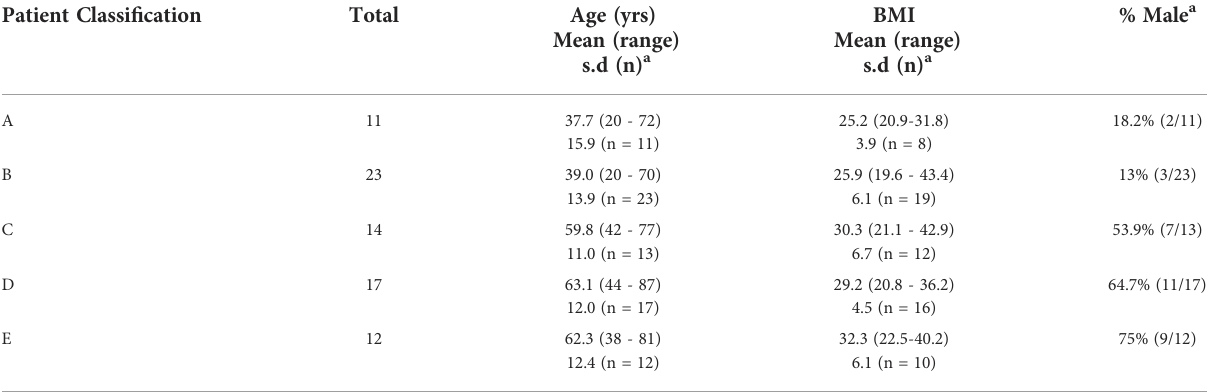
TABLE 3 Demographic data from patient subset used in time course